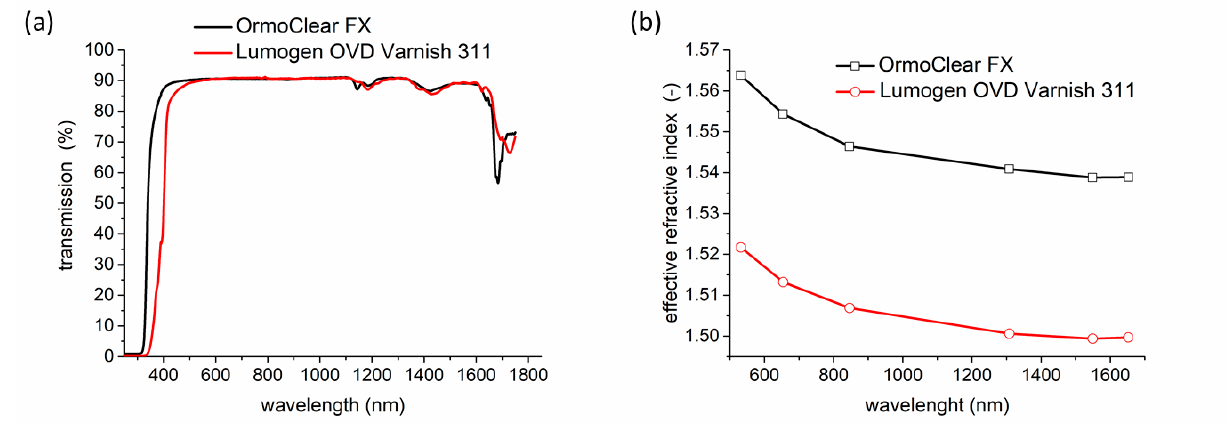
Figure 5. Properties of UV photopolymer Lumogen OVD Varnish 311 (BASF) and inorganic-organic hybrid polymer OrmoClear ® FX ( a ) the transmission spectra, ( b ) the refractive indices.